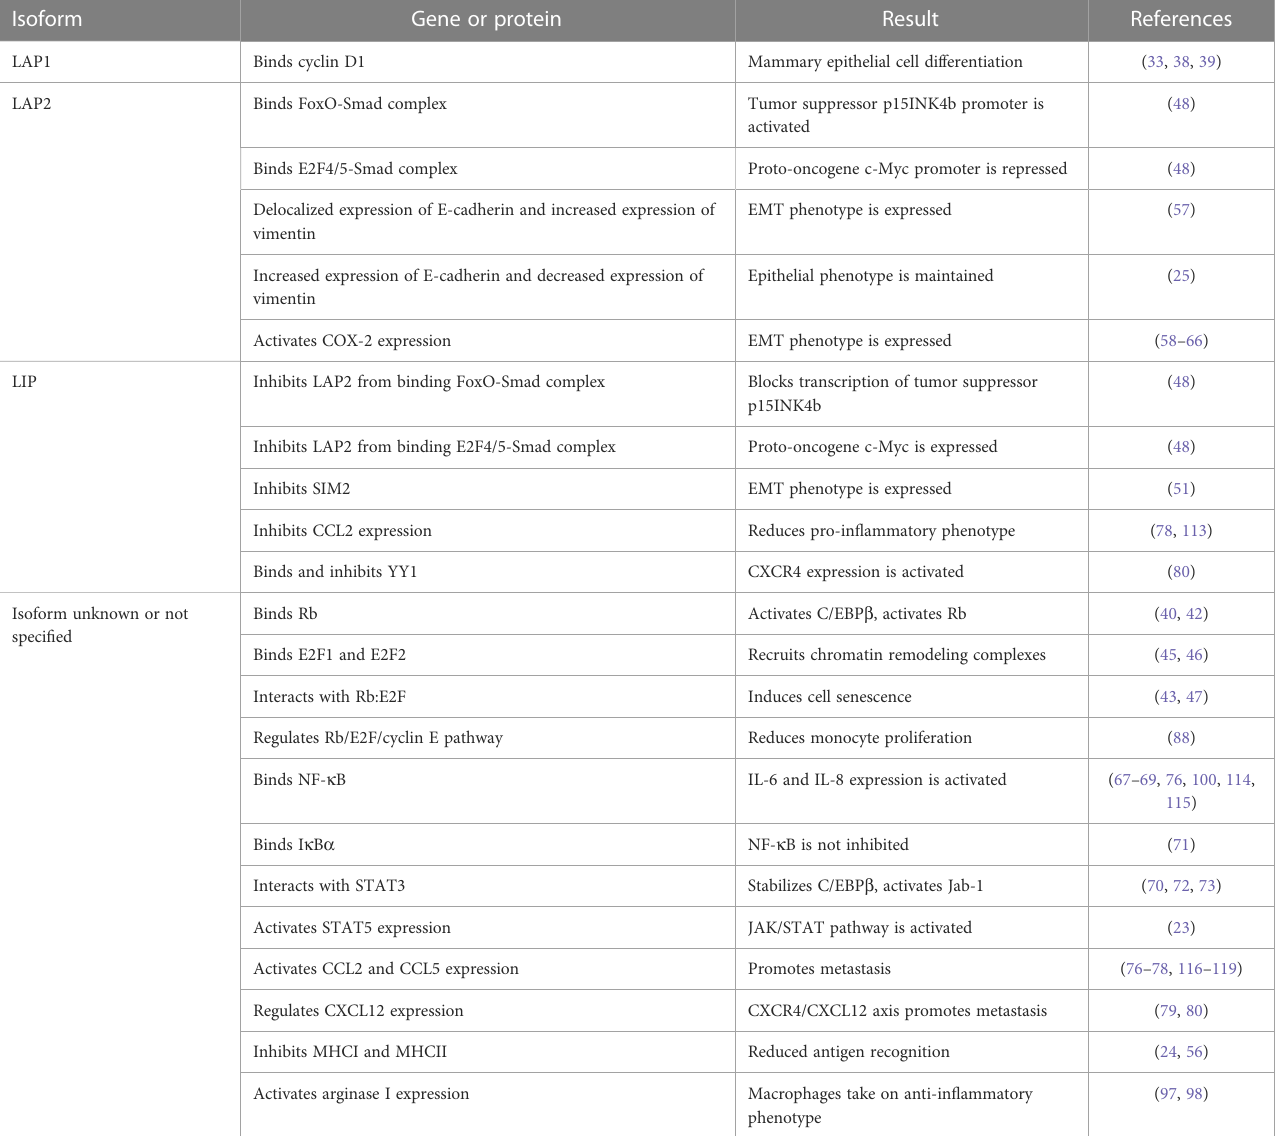
TABLE 1 Isoform-speci fi c regulation of gene expression and protein function. Isoform Gene or protein Result